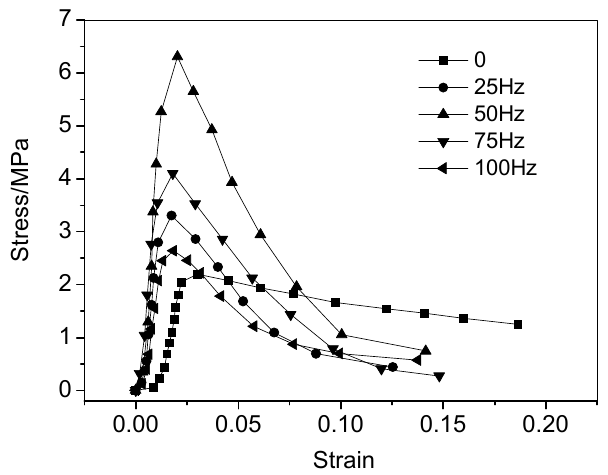
Figure 5. Stress-strain curves of the CA mortar with polymer emulsion incorporated after fatigue test under various frequencies.